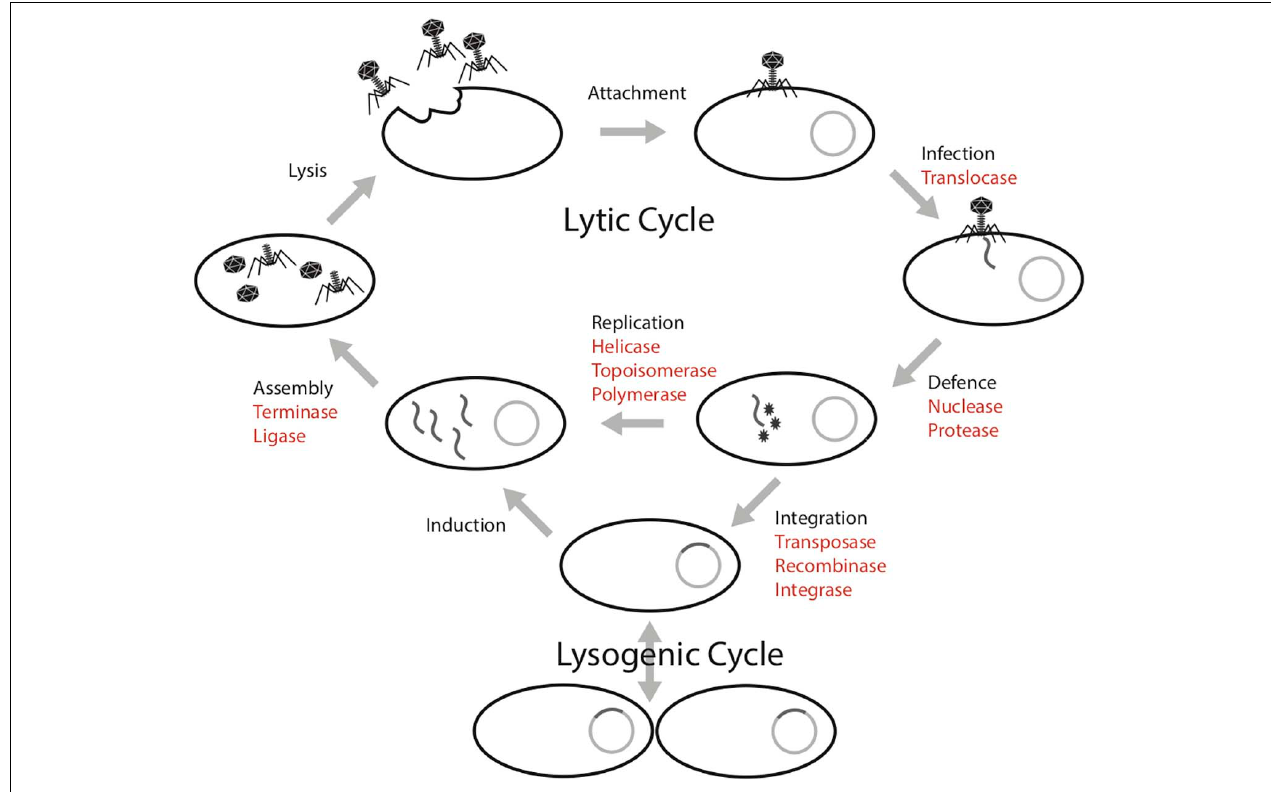
FIGURE 1 | Phage infection cycle with a list of proteins known to have an ATPase domain (highlighted in red), potentially involved in the energy consuming activities of each stage.